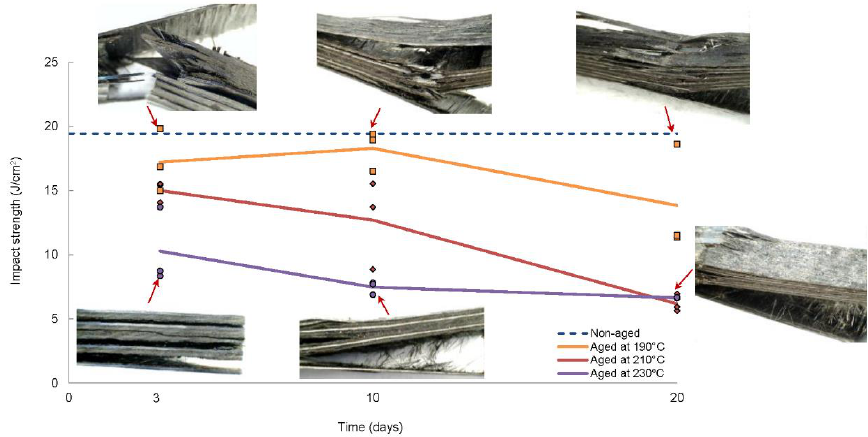
Figure 8. Average impact strength ( E c ) and failure modes of quasi-isotropic [0/90/ ± 45] 2s laminates aged at different temperatures: 3, 10 and 20 days ( E impact = 32.46 J).